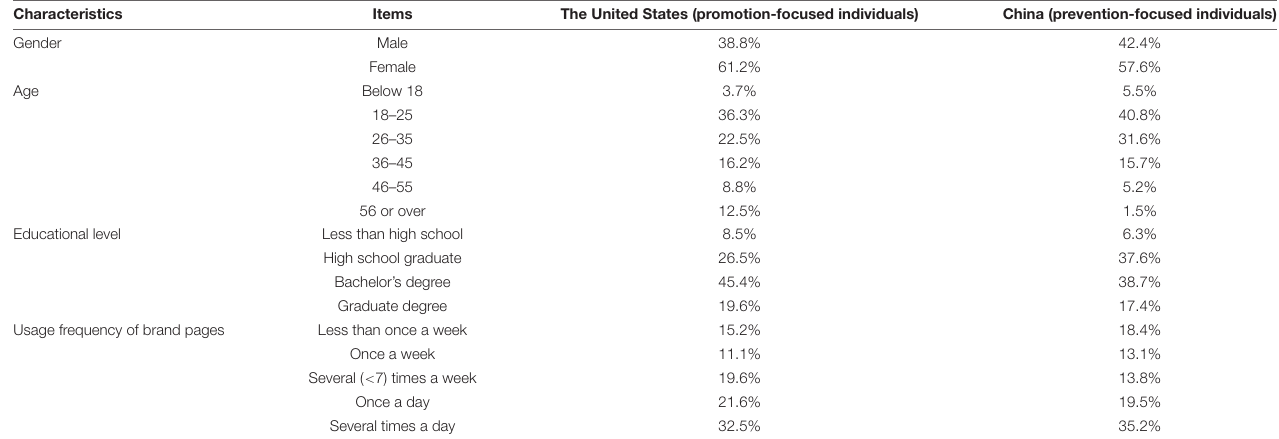
TABLE 2 | Sample demographic information.